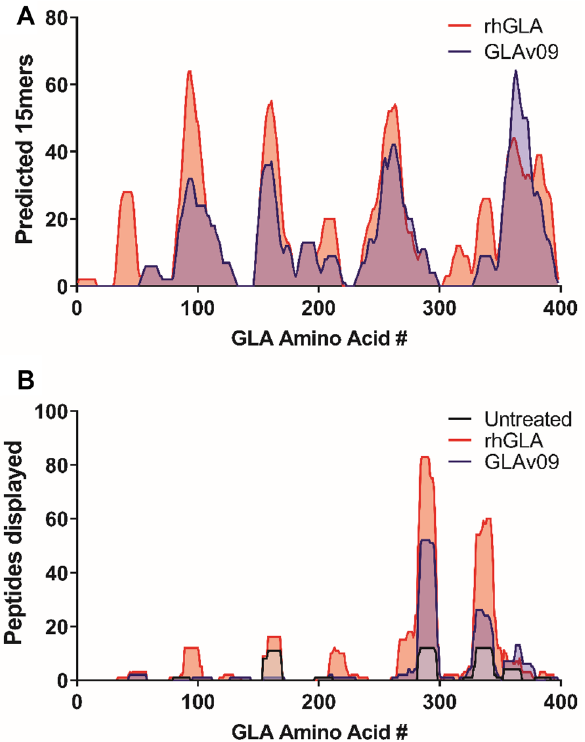
Figure 6. In silico and in vitro de-epitoping of GLA. ( A ) In silico assessment of 15-mer peptides of GLA (red) and GLAv09 (blue) using the IEDB software (https:// www. iedb. org). GLA and GLAv09 sequences were parsed into all possible 15-mer analysis frames, with each frame overlapping the previous one by 14 amino acids. The 15-mer analysis frames were evaluated for immunogenic potential by scoring their 9-mer core regions for predicted binding to eight common MHC-II HLA-DR alleles (DRB1*0101, DRB1*0301, DRB1*0401, DRB1*0701, DRB1*0801, DRB1*1101, DRB1*1301, and DRB1*1501). ( B ) MHC-associated peptide proteomics of peptides displayed on dendriticcells from buffer (grey), GLA (red), and GLAv09 (green). Histograms indicate the number of displayed peptides comprising the indicated amino acid across the entirety of the GLA